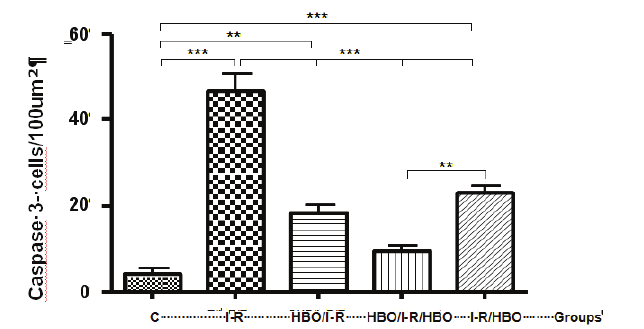
FIGURE 8 - Caspase-3 expression levels in the experimental and Control groups. The best result was achieved for the HBO/I-R/HBO group, with statistical